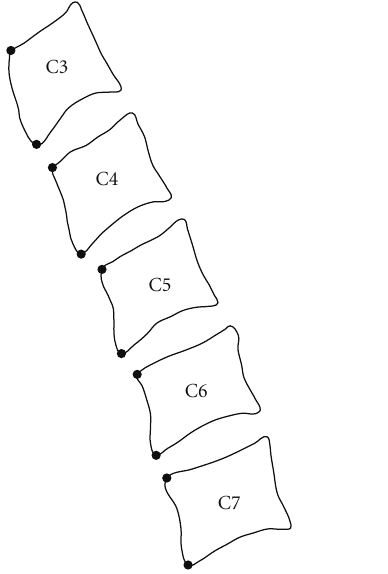
Figure 2: Landmarks for the spine curvature modelization.